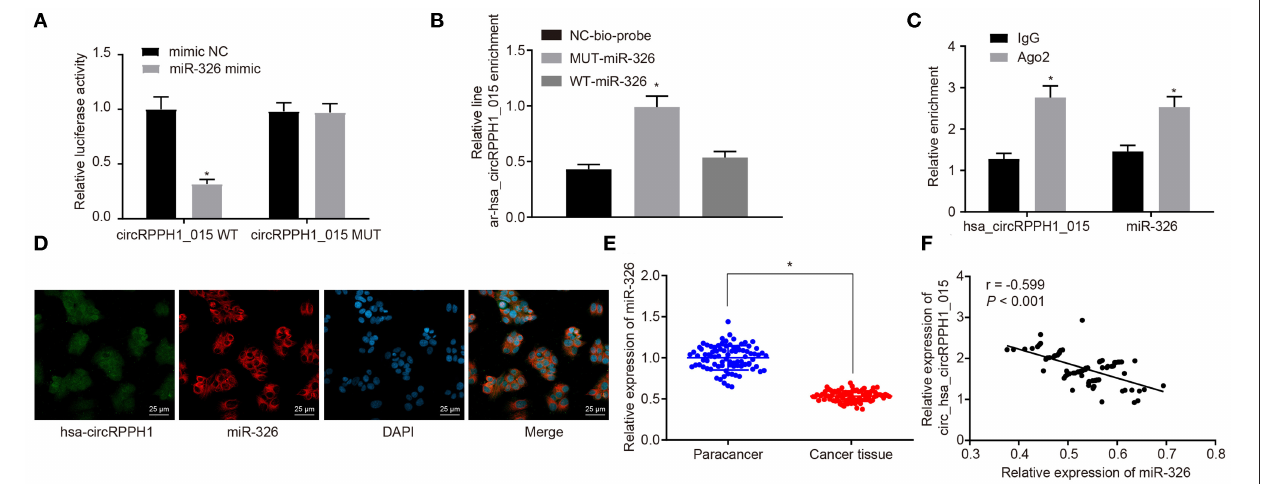
FIGURE 4 | The miR-326 expression was inhibited by hsa_circRPPH1_015. (A) Verification of the binding between hsa_circRPPH1_015 and miR-326 by dual-luciferase reporter gene assay in MCF-7 cells, * p < 0.05 vs. the si-NC group (MCF-7 cells transfected with si-NC). (B) The linear-hsa_circRPPH1_015 enrichment relative to NC-bio-probe detected by RNA pull-down experiment in MCF-7 cells, * p < 0.05 vs. the NC-bio-probe group (MCF-7 cells treated with NC-bio-probe). (C) The enrichment of Ago2 relative to IgG detected by RIP experiment in MCF-7 cells, * p < 0.05 vs. the IgG group (MCF-7 cells treated with IgG). (D) The cellular localization of hsa_circRPPH1_015 and miR-326 tested by FISH in MCF-7 cells. (E) The expression of miR-326 in adjacent normal tissues and BC tissues assessed by RT-qPCR, * p < 0.05 vs. the adjacent normal tissues. (F) Pearsons’ analysis of the correlation between hsa_circRPPH1_015 and miR-326. The quantitative analysis results were measurement data and compared by paired or unpaired t -test between two groups and by one-way ANOVA among multiple groups. Values were obtained from three independent experiments. BC, breast cancer; ELK1, ETS-domain containing protein; RT-qPCR, reverse transcription quantitative polymerase chain reaction; IgG, immunoglobulin G; RIP, RNA binding protein immunoprecipitation; si-NC, small interfering RNA-negative control; ANOVA, analysis of variance.